Question: Write a caption explaining this figure to a reader.
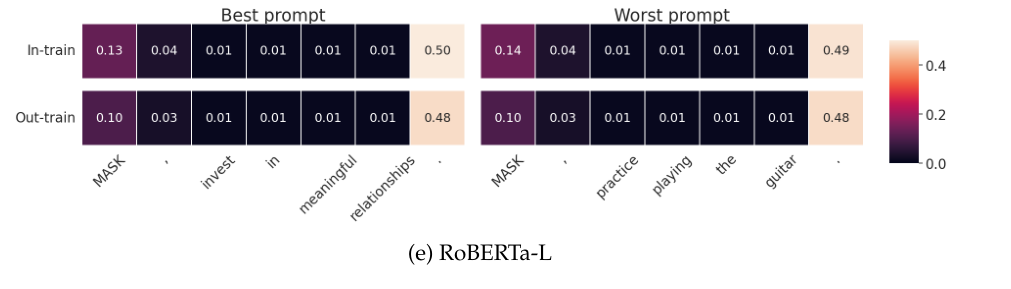
Answer: Attention heatmaps of the best and the worst prompts across 5 models on the dev set averaged over all attention heads and layers. The attention weights corresponding to each prompt’s “MASK” token are used and averaged over the In-train and Out-train PER sets separately.